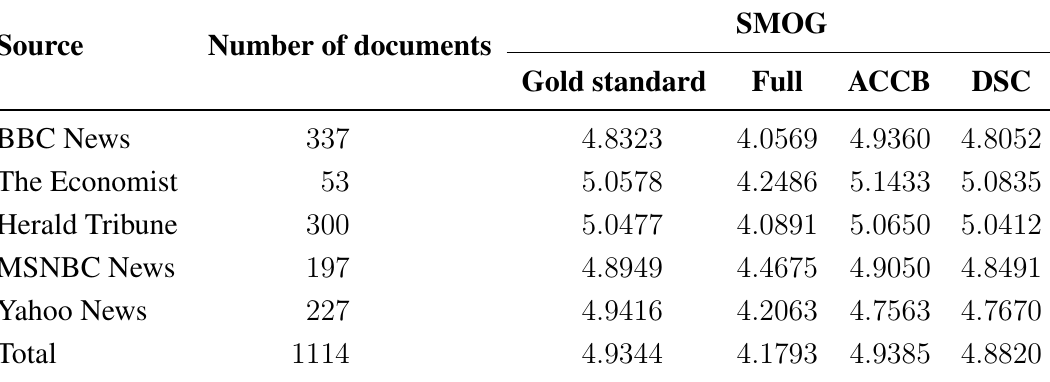
Table 2. Average SMOG index value for web documents based on the actual article text, the full text and after cleaning the document using the content extraction methods ACCB and DSC.